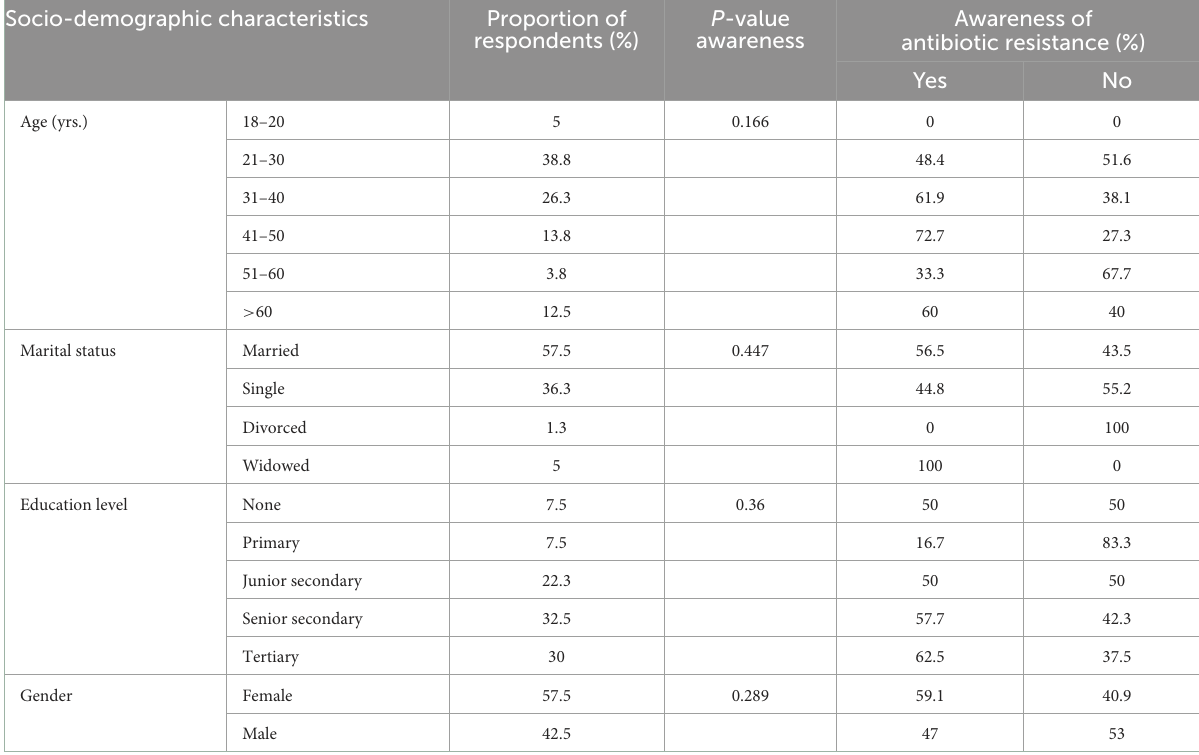
TABLE 3 Broiler farmers’ social demographic characteristics and awareness level on AMR ( N = 80). Socio-demographic characteristics Proportion of